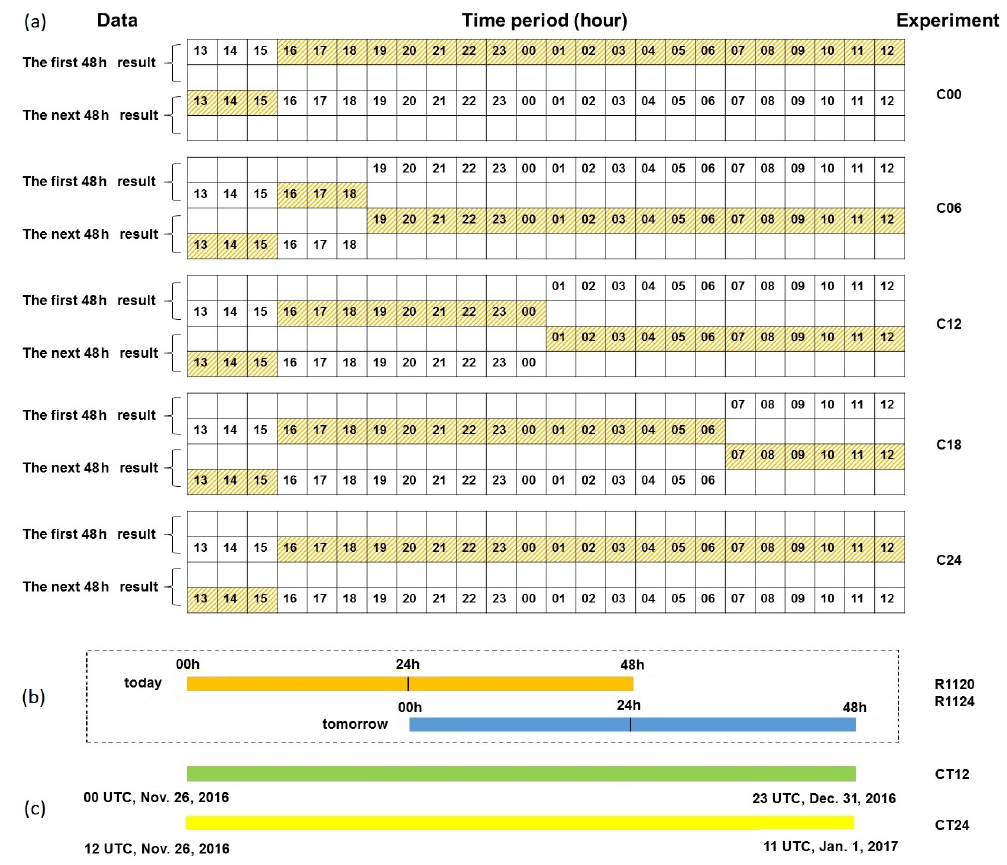
Figure 7. Time period for each initial condition experiment. Panel (a) shows the time period for the clean initial condition experiments (denoted using C). The output files from CAMx were initialised at 13:00 UTC every day, and the CAMx model forecasted the next 48h of PM 2 . 5 concentrations in each simulation cycle. The C00, C06, C12, C18, and C24 sensitivity experiments extract different time periods (0–24, 6–30, 12–36, 18–42, and 24–48h respectively) in each output file as valid data, represented by the grids with a number in them. Each grid represents an hour, and the numbers in the grids indicate the hours of the data. The grids with numbers in them represent the valid time period for each output file. The 24h of data from a day is cut and merged from 16:00UTC in the valid time period of each output file to analyse from 00:00 Beijing time (16:00UTC) every day. The shaded grids represent the data for 1 single day. Panel (b) shows the time period for the restart experiments (denoted using R). The meteorological data from the 12–36h period were extracted to estimate the PM 2 . 5 concentrations by restarting the simulation. The first day of the simulation starts at 12:00UTC, and the following days start at 00:00UTC. Panel (c) shows the time period for the continuous simulation experiments (denoted using CT). The meteorological data from the 12–36h period were cut and merged into one file for CT12, and data from the 24–48h period were cut and merged for